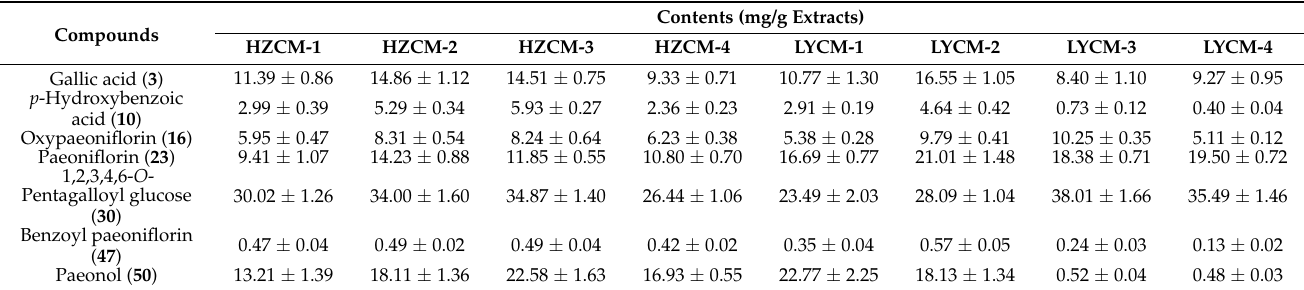
Table 2. Contents of four phenols and three monoterpenoids in the Cortex Moutan extracts determined using HPLC-DAD